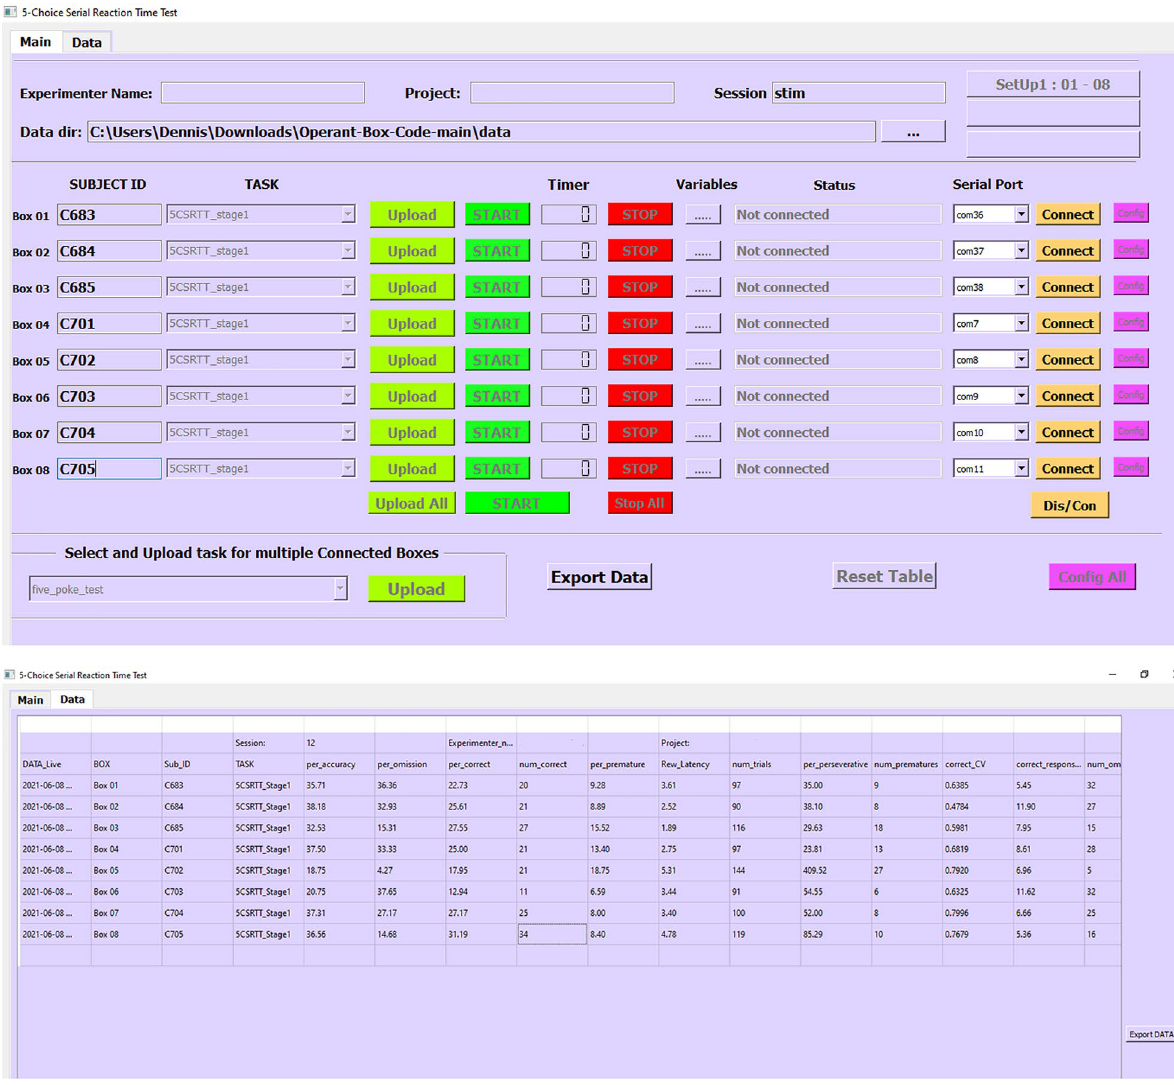
Figure 4. Graphical User Interface (GUI). ( a ) Main panel of the multi-control pyOS-5 GUI that allows to connect and control up to 8 boxes at the same time, whereby each box can run a different task file, if necessary. Multiple GUIs can be run in parallel. ( b ) Data panel of the same GUI displaying relevant behavioural performance parameters that are continuously updated and that can be directly exported as csv-file at the end of the